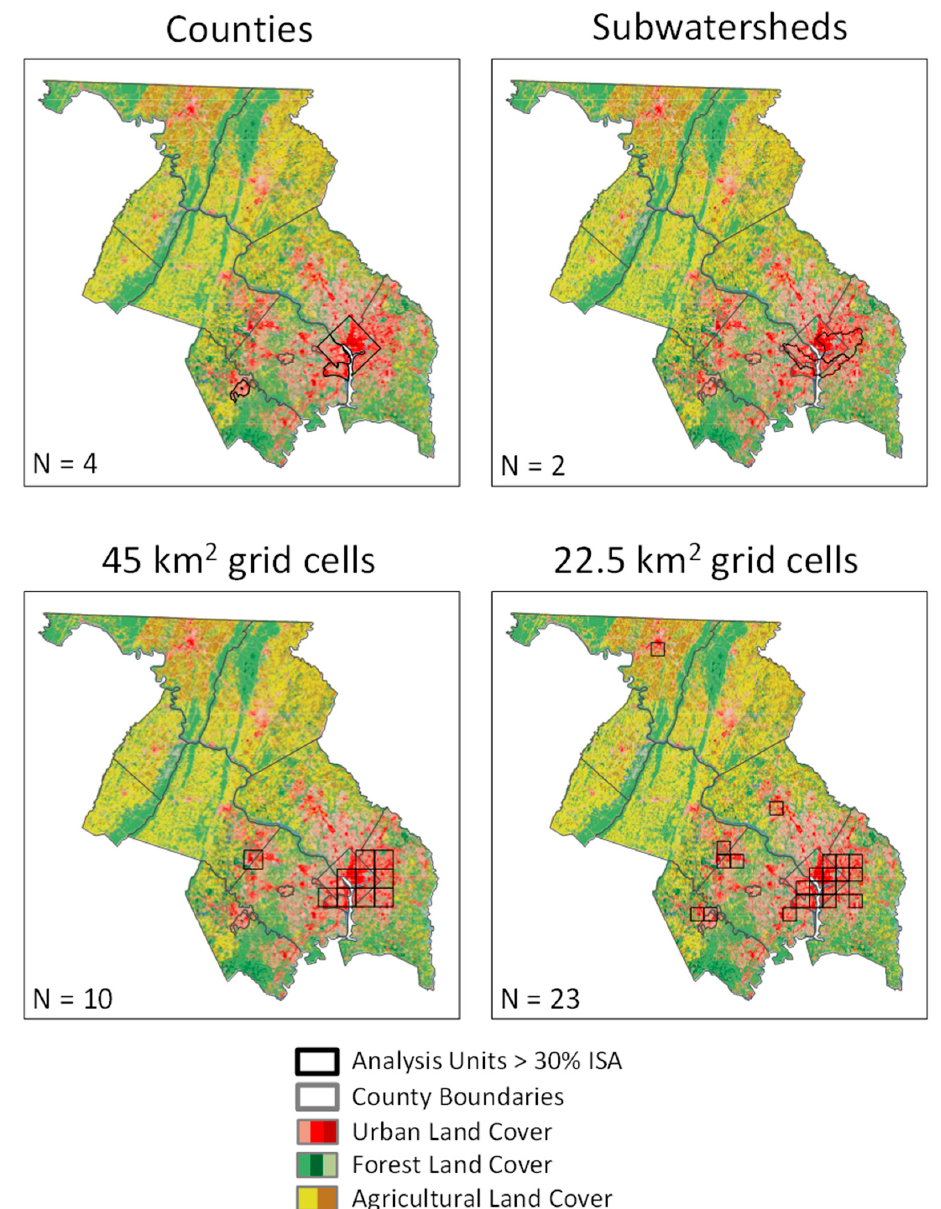
Figure 8. Maps of the study area showing the distribution of analysis units with >30% ISA, the threshold beyond which units exhibit a burial/ISA ratio above 1:1. Land cover data is the 2006 NLCD [22]. One grid cell, centering on Hagerstown, MD (Figure 8), falls just above the 30% ISA threshold, with recent and rapid development around the intersection of Interstates 70 and 81 leading to a very high ratio of burial per unit ISA (Figure 7D, yellow oval). Additional cells, including Springfield, VA (I ‐ 95 corridor), Manassas, VA (I ‐ 66 corridor), and in Prince George’s County, MD (I ‐ 495 corridor), fall on the 1: line, having managed to maintain significant natural land cover (Figure 8) despite centering on significant transportation corridors. A grid cell in Prince William County, VA, adjacent to Manassas, and one cell centered on the I ‐ 270 corridor in Montgomery County, MD, exhibit burial/ISA ratios just below 1:1. Two additional grid cells with >30% ISA fall well below the 1:1 line (Figure 7D, green oval), and include the areas around Herndon, VA, and suburban Prince George’s County, MD, that exhibited similarly low ratios at the 45 km 2 scale, as discussed above.